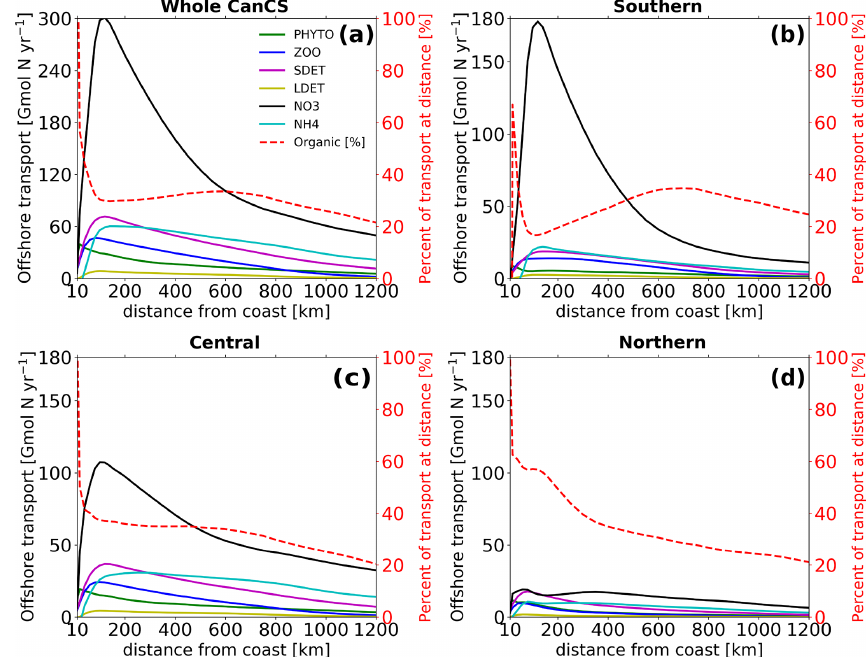
Figure 5. The net offshore transport of each pool of nitrogen (phytoplankton, zooplankton, small and large detritus, nitrate, and ammonium) as a function of the distance to the coast in the three subregions (left axis). The fraction of organic nitrogen (in %) in the net offshore transport of nitrogen at each distance from the coast is shown on the right